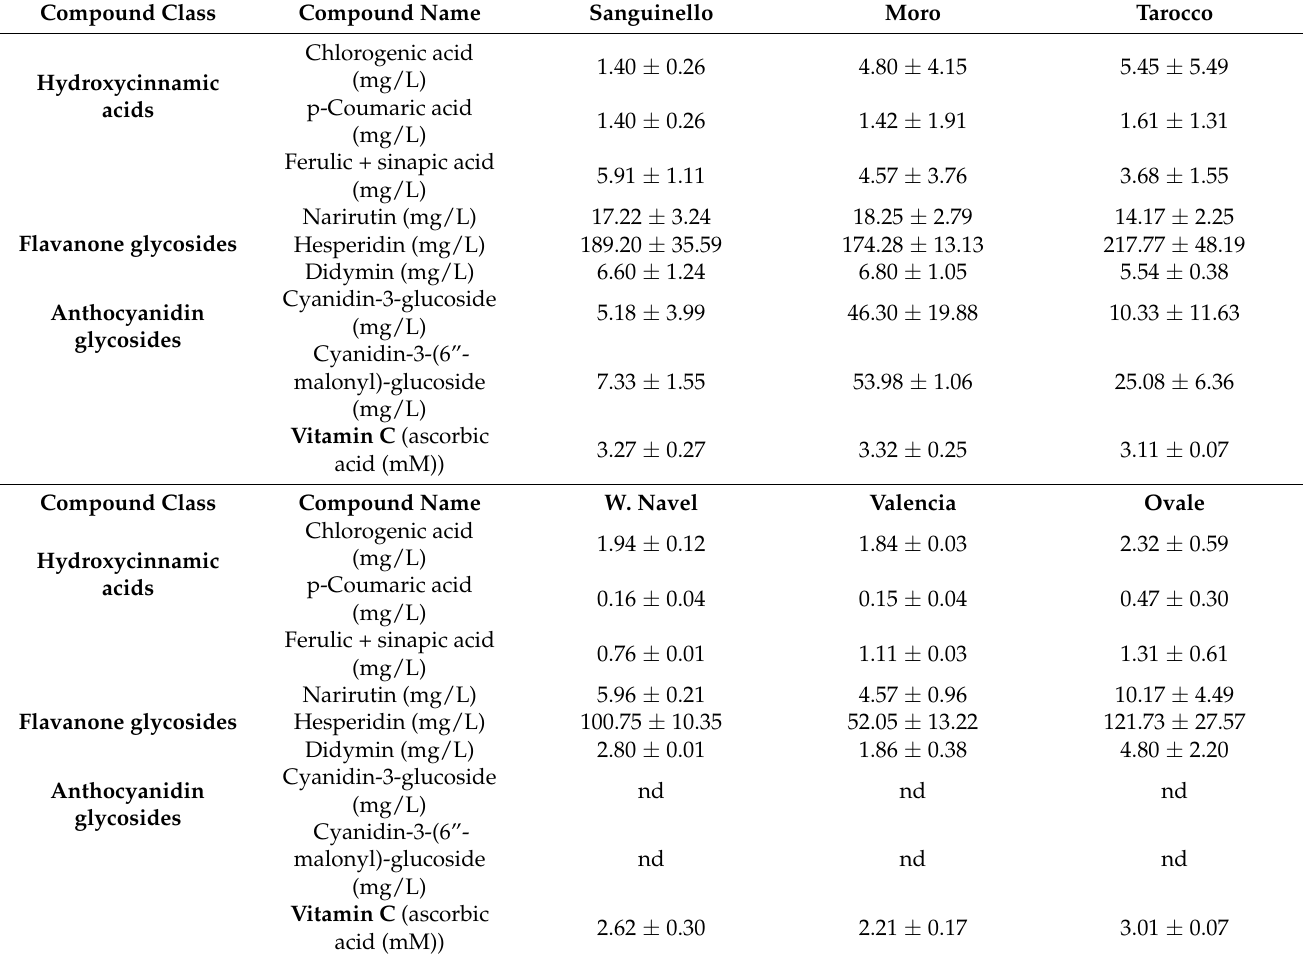
Table 2. Comparison of antioxidant activity of fresh juices of pigmented sweet orange